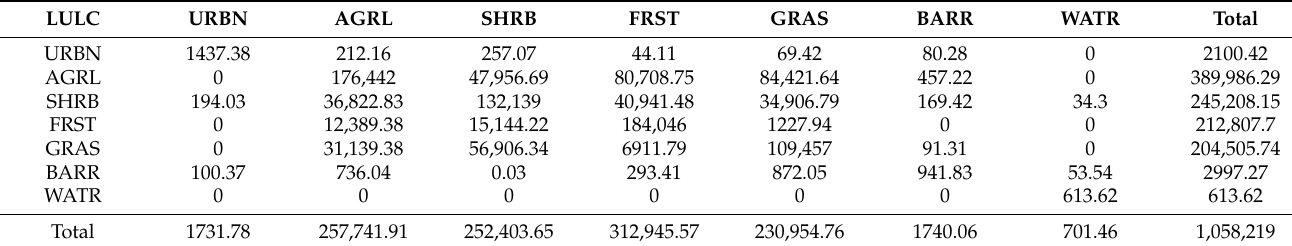
Table 4. LULC change matrix between the years 1986 and 2001